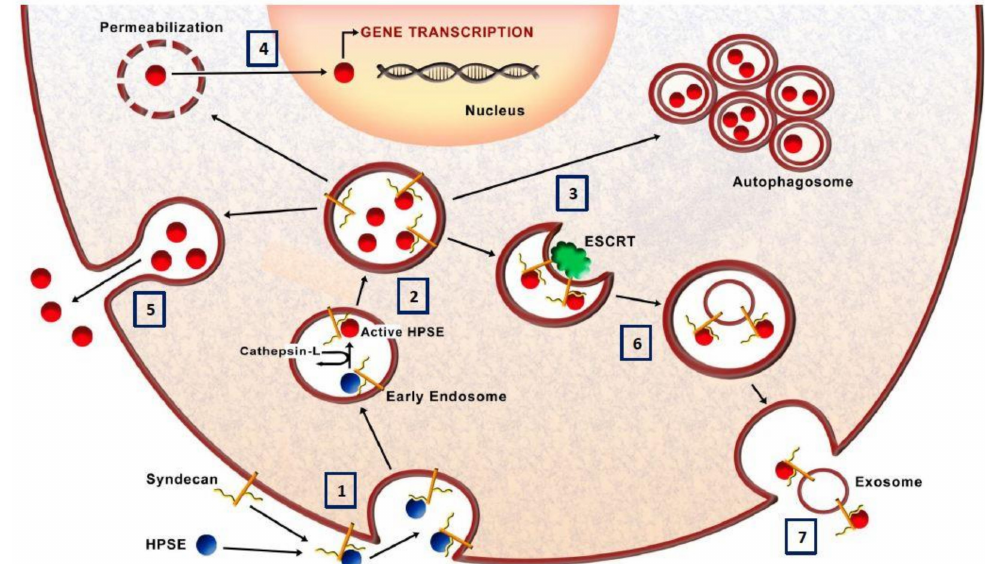
Figure 1. Schematic model of heparanase trafficking. ( 1 ) The inactive pro-HPSE in the extracellular spaces interacts with HS-proteoglycans such as syndecan-1 and the complex is endocytosed. ( 2 ) The fusion of endosomes with lysosomes, with the consequent acidification, induces the activation of HPSE exerted by the cleavage by cathepsin- L . ( 3 ) Here HPSE participates in the formation of autophagosome and thus controls the basal levels of autophagy. ( 4 ) HPSE can translocate into the nucleus where it can modulate gene transcription or ( 5 ) it can be secreted in the extracellular space. ( 6 ) Moreover, HPSE modulates the formation and the release of exosomes and ( 7 ) active HPSE is also released and anchored to syndecan on exosome surfaces. Collectively, by